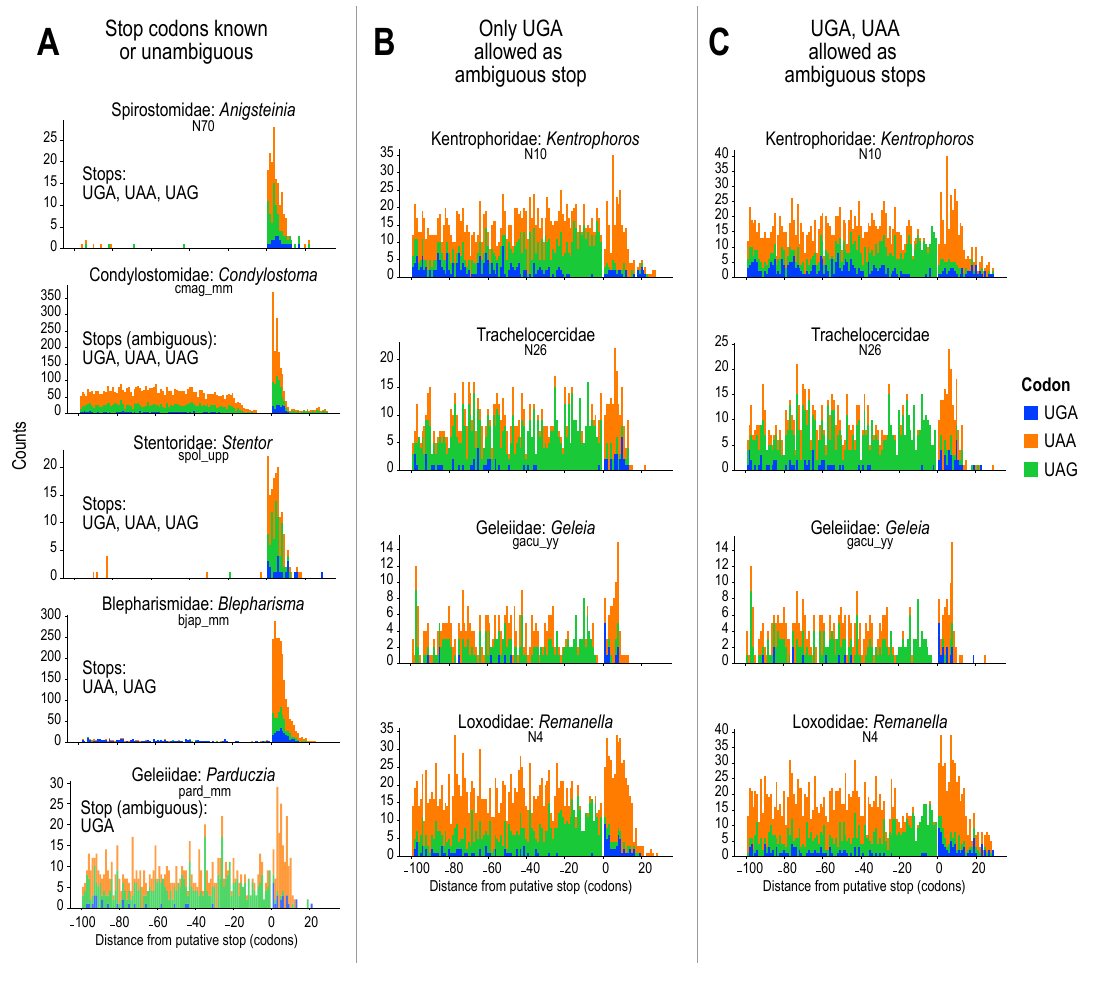
Figure 5 . Depletion of in-frame coding “stop” codons in the coding sequence (negative coordinates) immediately before the putative true stop codon (position 0) and their enrichment in the 3’-UTR (positive coordinates). Representative library with highest number of assembled full length contigs chosen per taxon. ( A ) Codon counts for UGA (blue), UAA (orange), and UAG (green) before and after putative true stop in Condylostoma magnum (uses all three as ambiguous stops), and three heterotrichs with unambiguous stops. ( B ) Codon counts for karyorelicts if only UGA is permitted as a stop codon. ( C ) Codon counts for karyorelicts if both UGA and UAA are permitted as stop